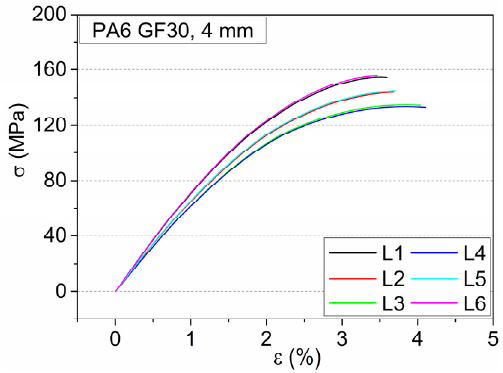
Figure 4. Stress–strain diagram of PA6 GF30 depending on the position in the injection molded plate.